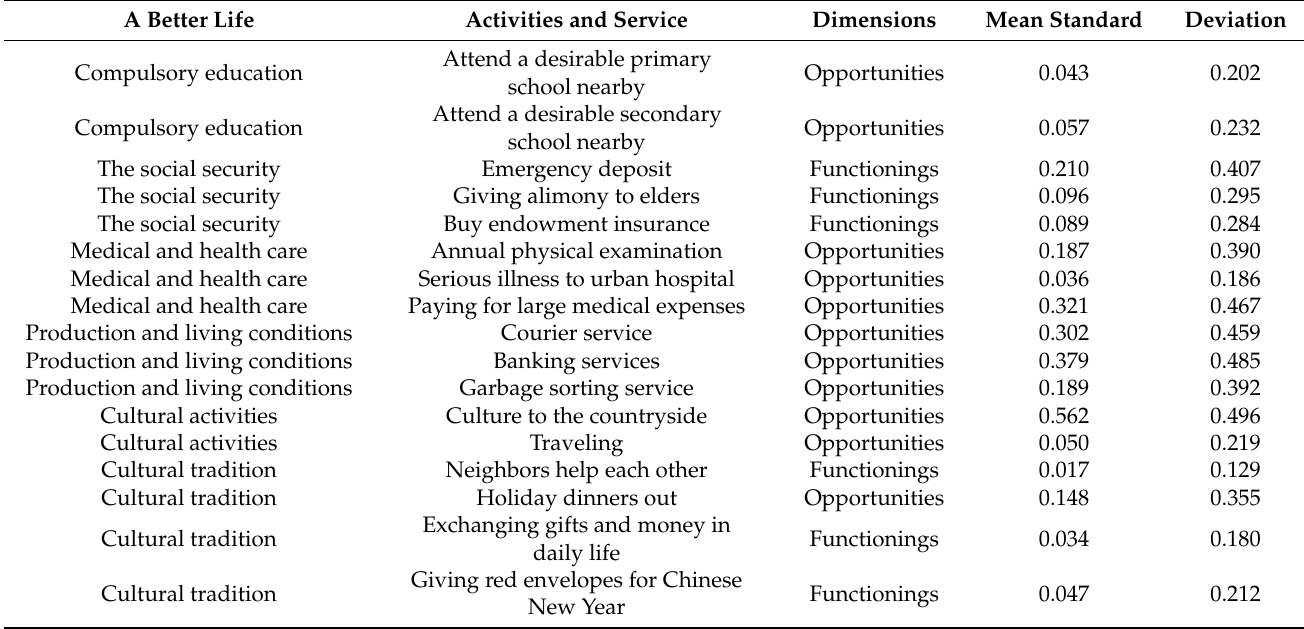
Table 2. Descriptive statistics of deprivation